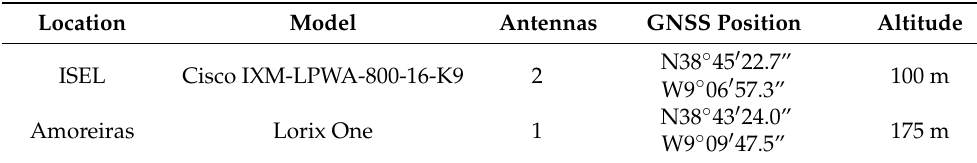
Table 1. Gateways